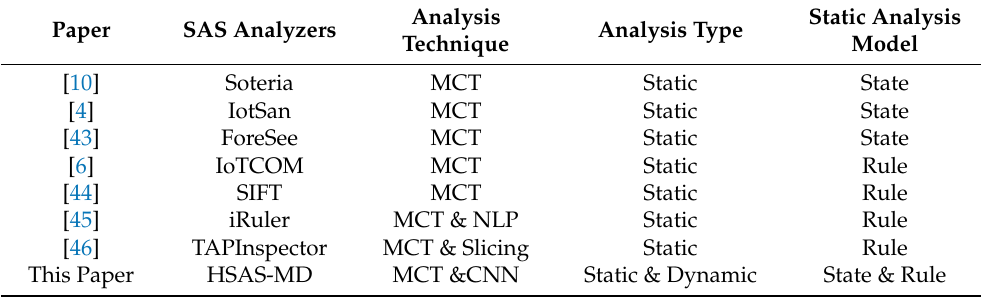
Table 5. A comparison between various SASs based on MCT.